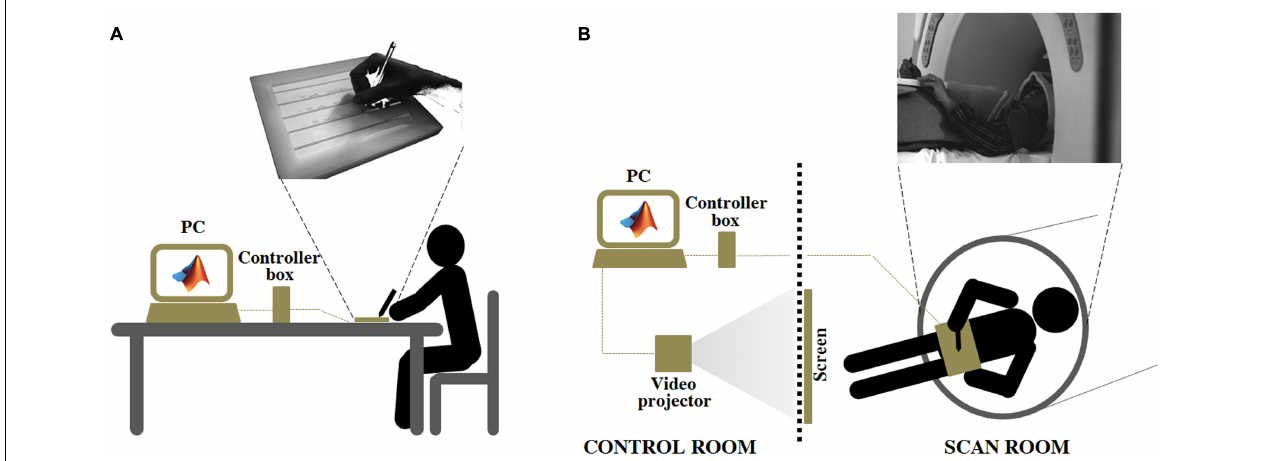
FIGURE 1 | Experiment 2: Experimental set up adopted for the ecological handwriting movement condition, outside (A), and inside (B) the magnetic resonance environment. In the condition OUTSIDE the subjects, seated at a table, used an ink stylus to write on a paper with black, horizontal lines positioned over the SMART TAB surface. The experimenter monitored the formation of the written trace on the computer screen connected to the MR tablet through the controller box. The computer managed the acquisition by means of a custom-made MatLab R (cid:13) software. In the condition INSIDE the subject laid down inside the magnetic bore. The MR tablet was positioned on her/his body at the level of the pelvis. A pad was placed under the tablet to help the subject to keep a position as comfortable as possible during the handwriting movement. A plastic, MR-compatible stylus was used to perform the task directly on the tablet surface. The participant had a simultaneous visual feedback of her/his motor performance by looking at a mirror positioned on the head coil. The mirror reflected the images projected onto a white screen placed inside the scan room, where a video-projector, connected to the computer used for the acquisition, displayed the written trace. The video-projector, the controller box and the computer were placed in the control room.